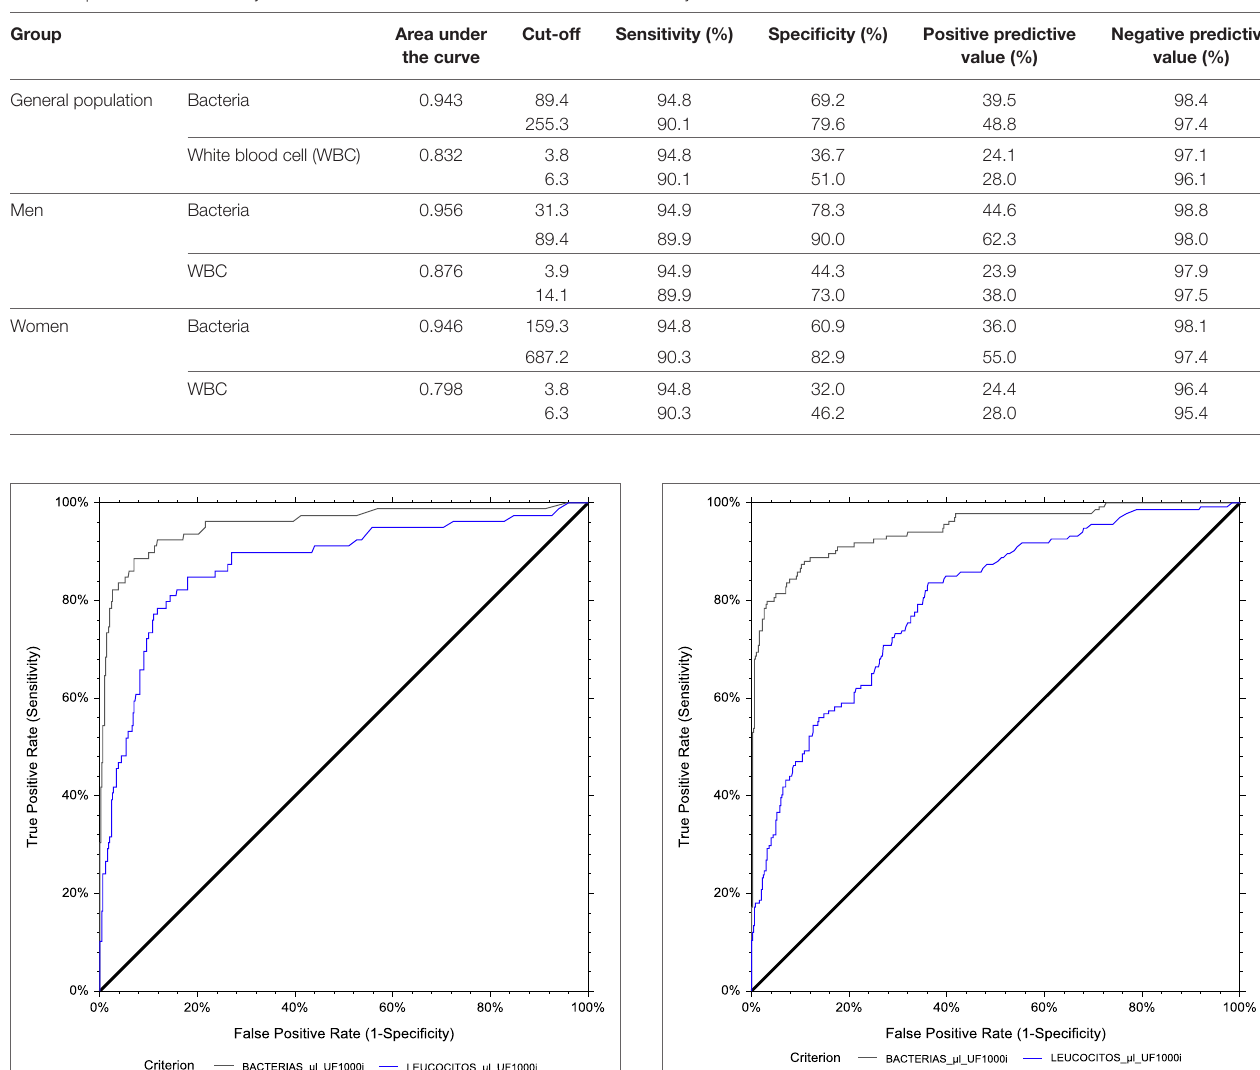
FIgURe 12 | ROC curve analysis for women. The area under the curve (AUC) is 0.946 for bacterial count and 0.798 for leukocyte count by flow cytometry, using culture as the reference method.